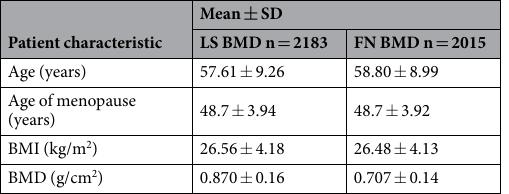
Table 4. Baseline characteristics of the OSTEOMED2 cohort. Abbreviations: BMI = body mass index; BMD = bone mineral density; LS = lumbar spine; FN = femoral